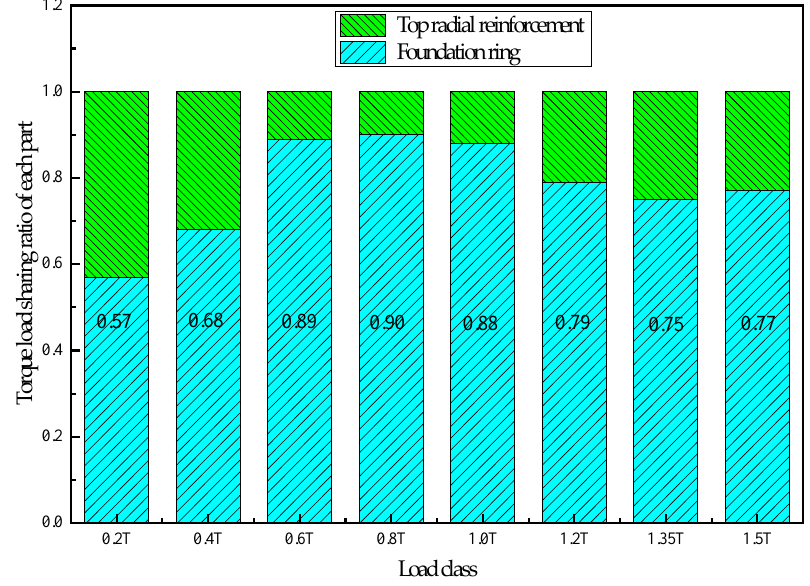
Figure 13. Torque load sharing ratio of specimen ZT-3.